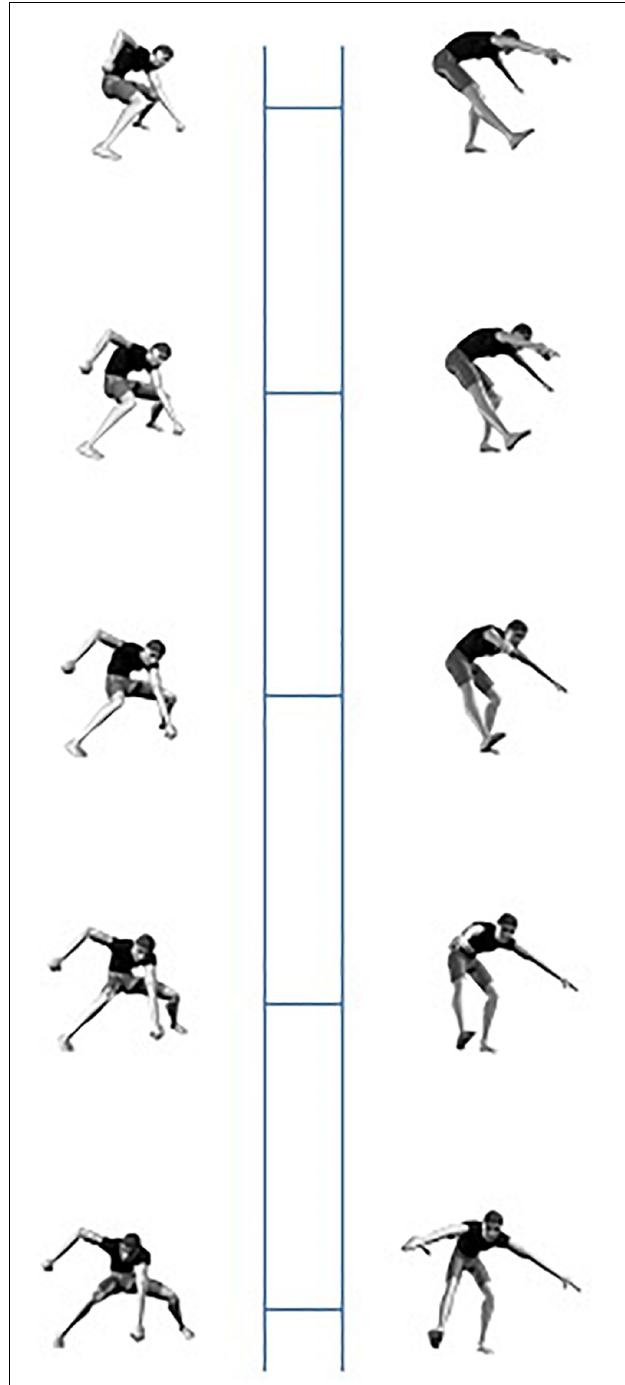
FIGURE 10 | Common representational space of two human body postures (each column depicts a particular postures in four different depth orientations; in each row two similar but distinct postures in the same depth